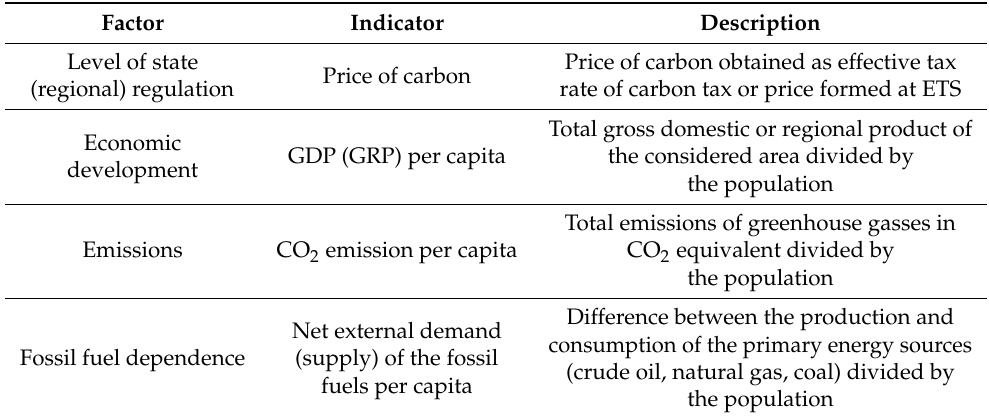
Table 1. Main factors and indicators used for